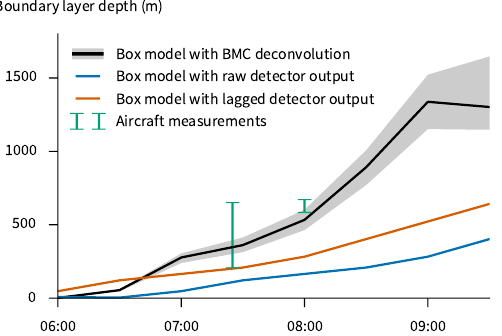
Figure 9. Box model analysis of deconvolved and scaled radon detector output. The 16th–84th percentile range is shaded grey. The mixing depth is calculated by assuming that radon is mixed homogeneously in a near-surface layer, with surface emissions of F Rn = 19 . 2mBqm − 2 s − 1 . The aircraft measurements of boundary- layer depth are computed from vertical profiles of temperature, wind speed, and humidity using the parcel method (lower limit of each bar) and bulk Richardson number methods (the upper limit of each bar). A critical Richardson number of 0.3 was assumed.